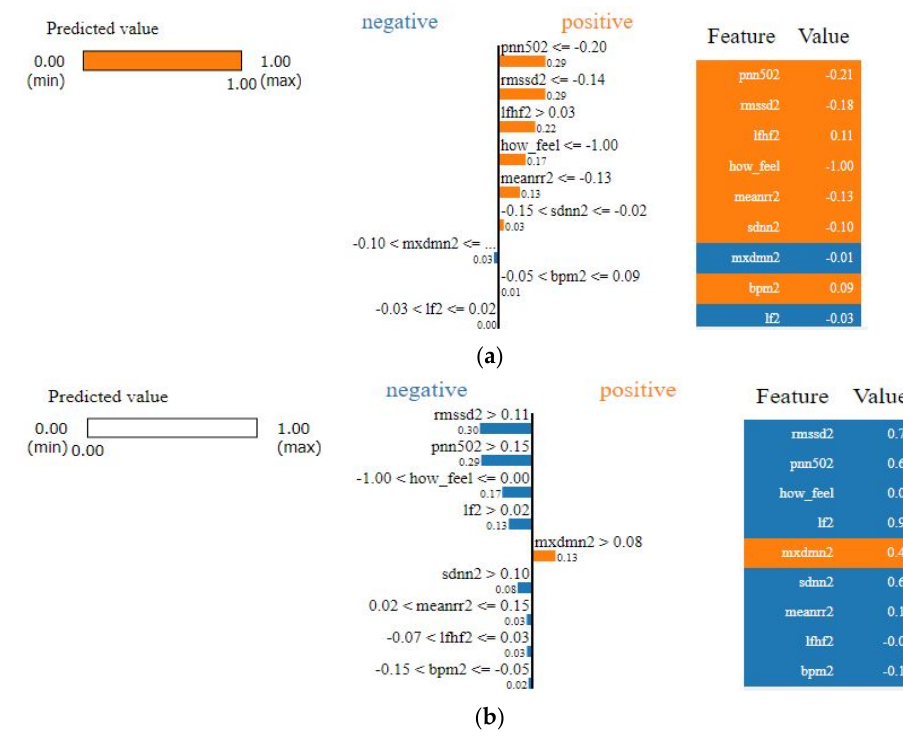
Figure 10. LIME explanation of the SVM classifier ( a ) for a positive case; ( b ) for a negative case. On the right-hand side of Figure 10, each feature is given a weight based on its importance to the target. In LIME taxonomy [47], this is calculated by re-sampling fake data points perturbing the real observation data (i.e., locality) and then computing the distance between the generated point and the observation. In our context, we can see that pNN50, RMSSD, LF/HF, how feel, and meanrr are the top five important features. To the left of the names and scores of the features in Figure 10a, the LIME explains